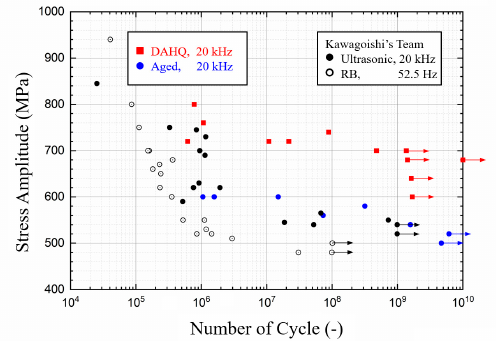
Figure 7. VHCF property comparison with Kawagoishi’s team [19–21,39,40].